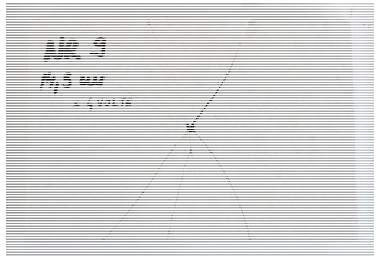
Figure 10. Impact curves of coupon NI3.